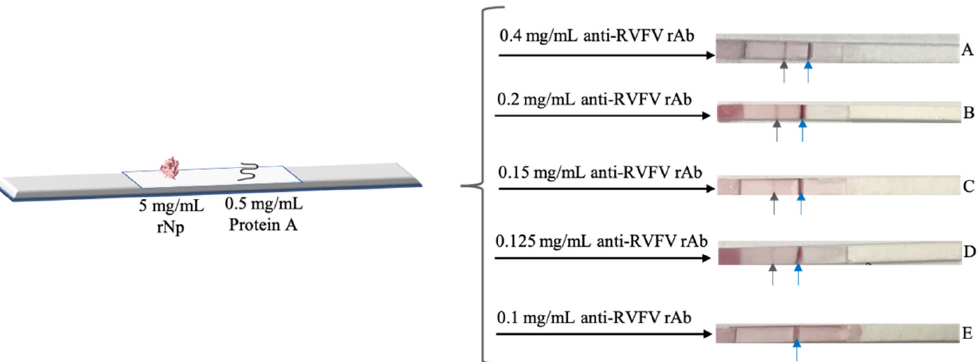
Figure 6. Assembled RVFV lateral flow assay strips testing the limit of detection with 5 mg/mL rNp on test line and 0.5 mg/mL ProA on the control line tested with various concentrations of anti-RVFV rAb. ( A – E ) shows the LFA results after testing with anti-RVFV rAb concentrations of 0.4, 0.2, 0.15, 0.125 and 0.1 mg/mL respectively. The black and blue arrows denote the test control lines, respectively.